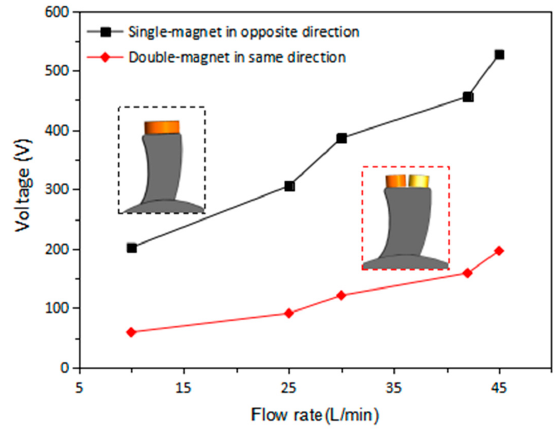
Figure 7. Open circuit voltage of EMG for single-magnet in opposite direction and double-magnet in same direction.